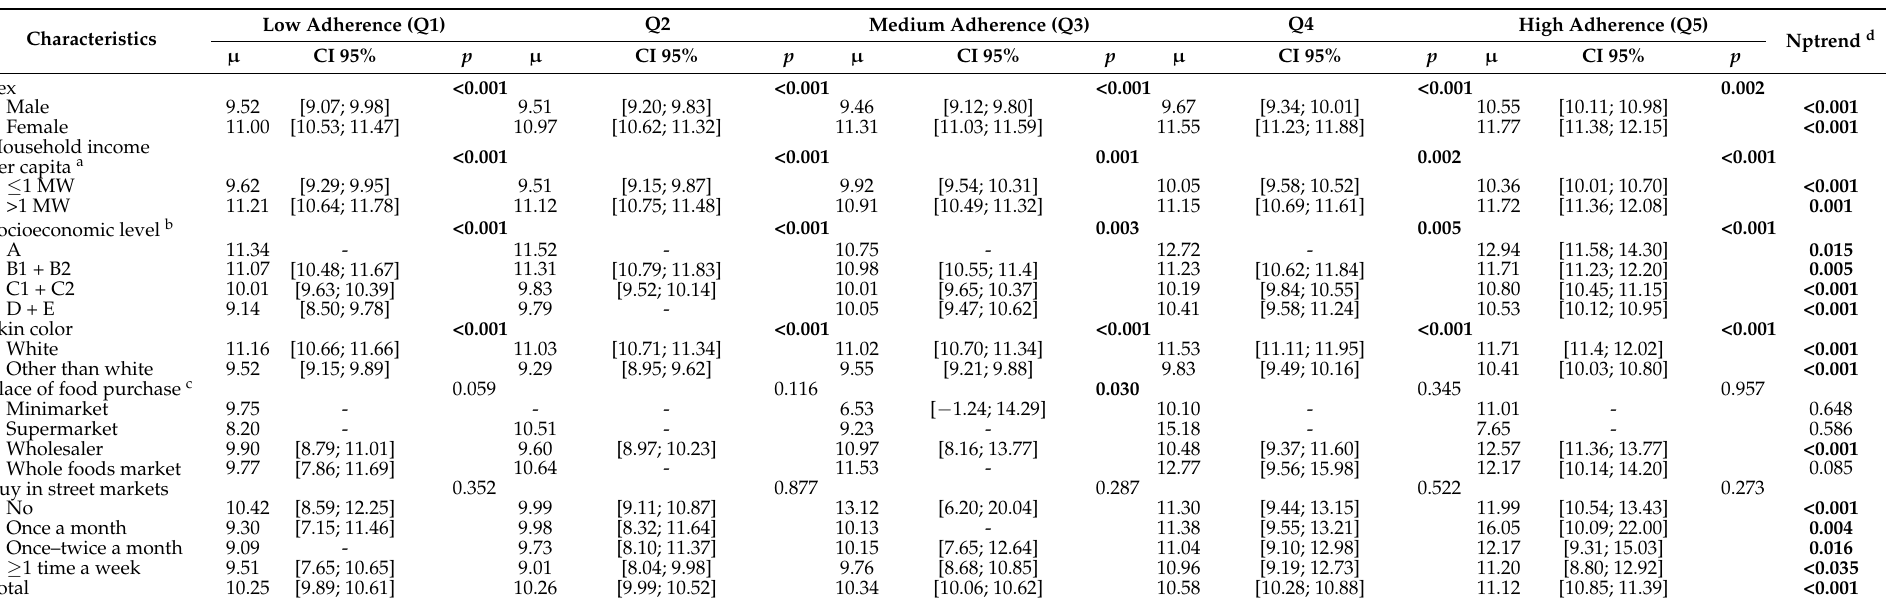
Table 2. Diet cost in quintiles of nutritional quality, according to socioeconomic, demographic variables, and food purchase profile. ISA-2015, Sao Paulo, Brazil.